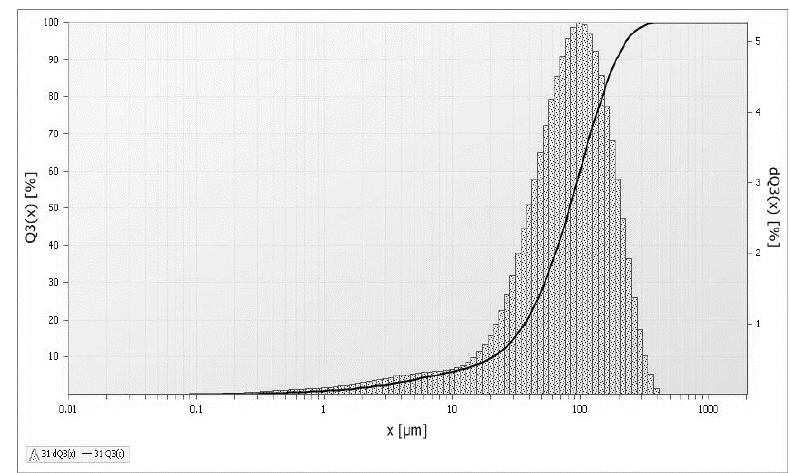
Figure 2. Curve of ODFA grain size.